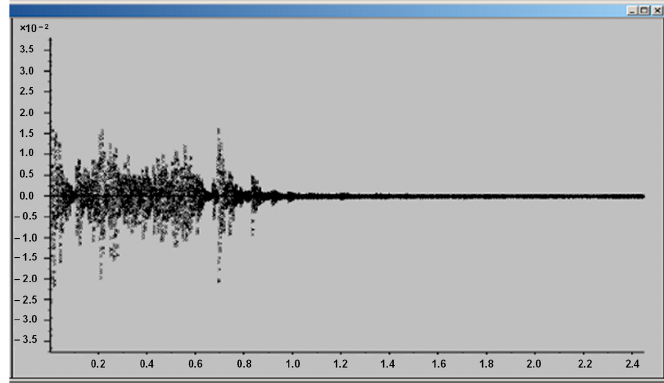
Figure 14. Data after nonelectric detonator vibration test and transition.